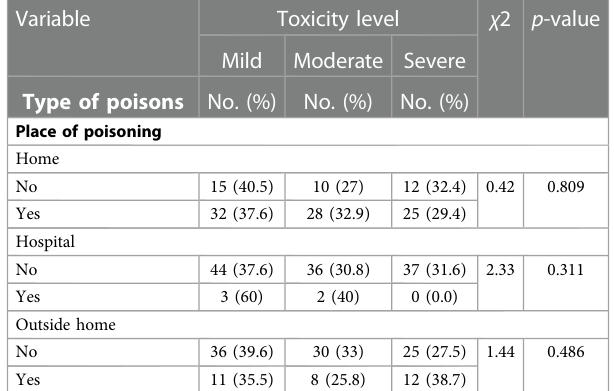
TABLE 6 Relationship between level of toxicity and poison forms, route and mode of poisoning, time of exposure, and place of poisoning (No.:122).